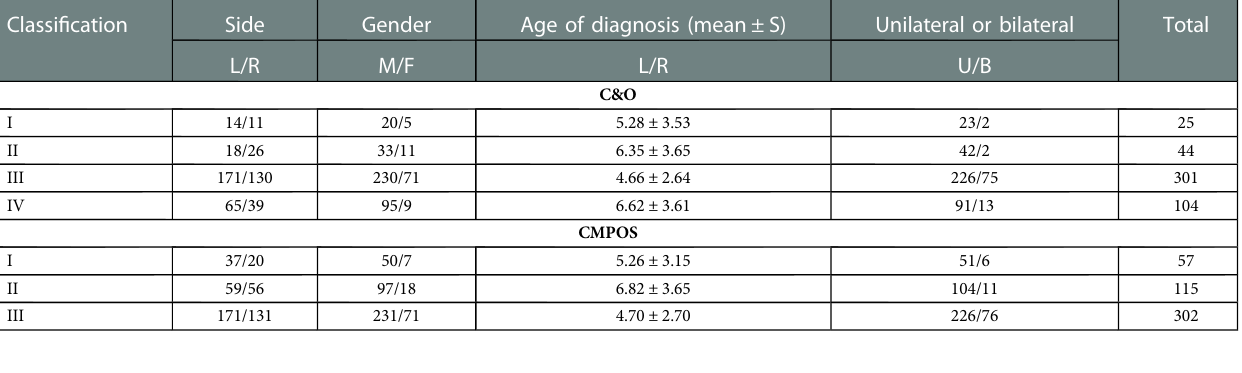
TABLE 2 Type of patients distribution in different pronation degree. Classi fi cation/(Percentage)